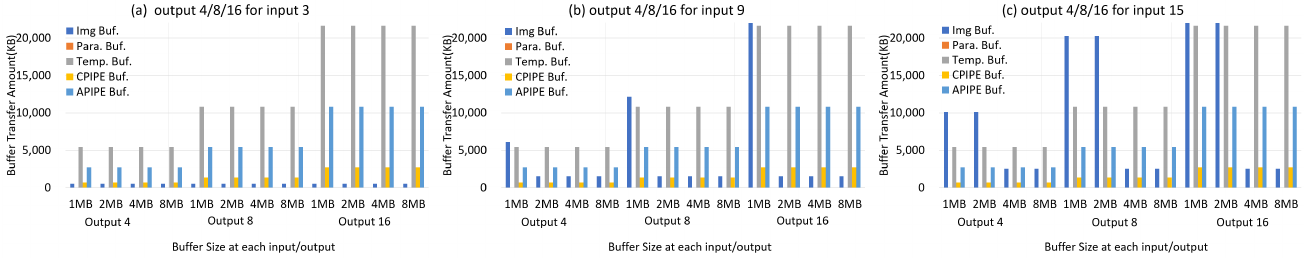
Figure 9. It plots the amount of data transferred between memory and each buffer according to the the buffer size from 1 MB to 8 MB for each CNN